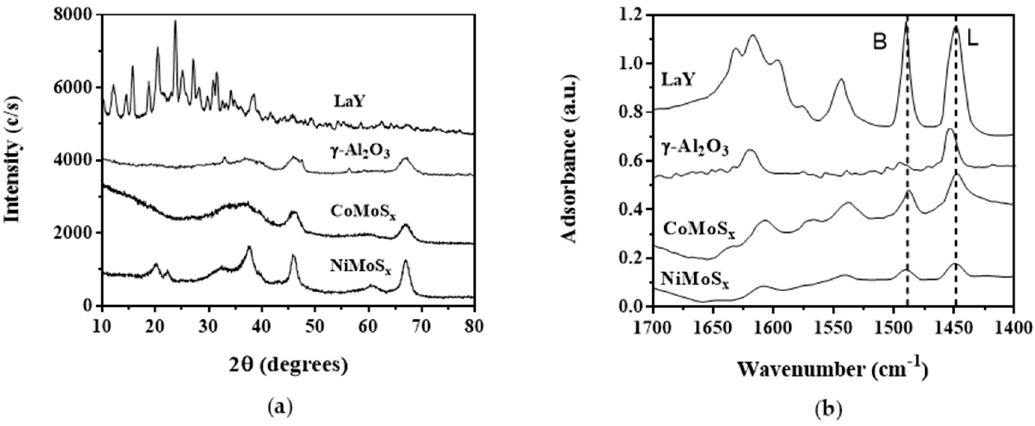
Figure 1. ( a ) X-ray diffraction patterns and ( b ) Fourier-transform infrared (FTIR) spectra of adsorbed pyridine of catalysts.